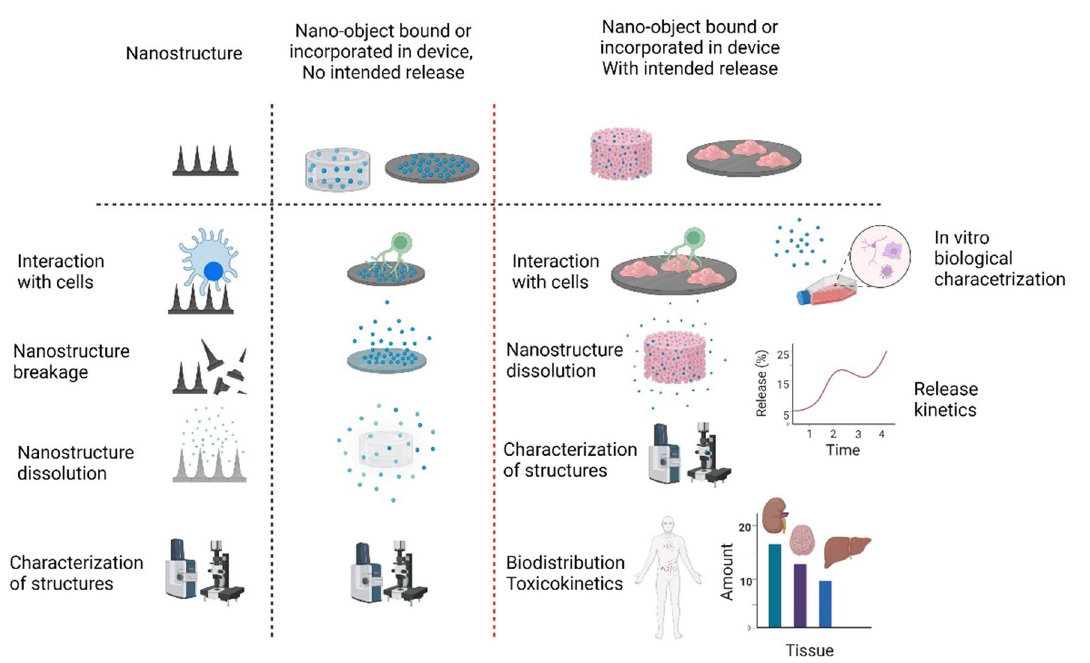
Fig. 4 Characterization requirements for medical devices containing nanostructures and nanomaterials as recommended by ISO/TR 10993–22. The extent of characterization is dependent on the type and state of nano-based medical devices. The nanomaterial exposure risk via direct con- tact or unintended nanoparticle leakage from the device needs to be considered in the device characterization to properly assess safety and effi- cacy of nanotechnology-based medical devices. The degradation or dissolution and stability of nanostructures in relevant biological media need to be monitored and characterized over the shelf life and active lifetime of medical devices. Finally, the structures need to be fully characterized both in vitro and in in vivo proxies to ensure the design and physicochemical properties do not compromise the safety and efficacy of the medical devices. The scrutiny of the evaluation will increase if the nanostructures are designed to release from the device or pose the risk of undesired release in biological fluids. In addition to the above-mentioned evaluations, further tests (e.g., biodistribution, toxicity, and release kinetics of nanomaterials) are required to ensure the nanomedical device is safe for use in the clinic. The ISO/TR 10993–22 standards provide a framework and guidelines for characterization of nanomaterials. More specific physicochemical characteristic testing of nanomaterials is detailed in ISO/TR 13014. The figure is drawn based on the information provided in ISO/TR 10993–22